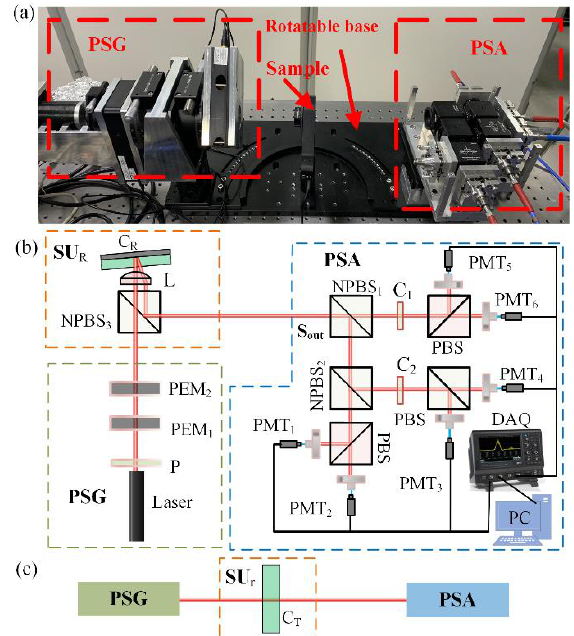
Figure 1. The high-speed MME: P - polarizer; PEM 1 and PEM 2 - photoelastic modulators; C 1 - quart-wave plate; C 2 - half-wave plate; C R - quartz multi-order quart-wave plate with a reflective layer; C T - quartz multi-order quart-wave plate; S –Sample; PBS - polarization beam splitter (PBS); NPBS 1 - 70:30 (R:T) non-polarization beam splitter (NPBS); NPBS 2 , NPBS 3 - 50:50 (R:T) NPBS; L - plano-convex lens; Ry- reflective layer; DAQ - oscilloscope; PC - personal computer; PMT - photomultiplier tube; (a) the MME prototype, (b) light path diagram of the reflection mode; (c) light path diagram of the transmission mode;